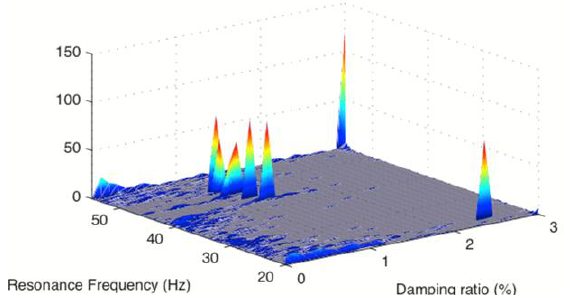
Fig. 10. Clusters of estimated poles from